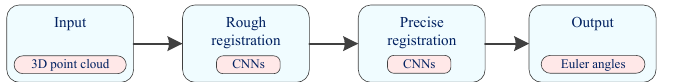
Figure 1. A block diagram of the proposed registration architecture using convolutional neural networks (CNNs).